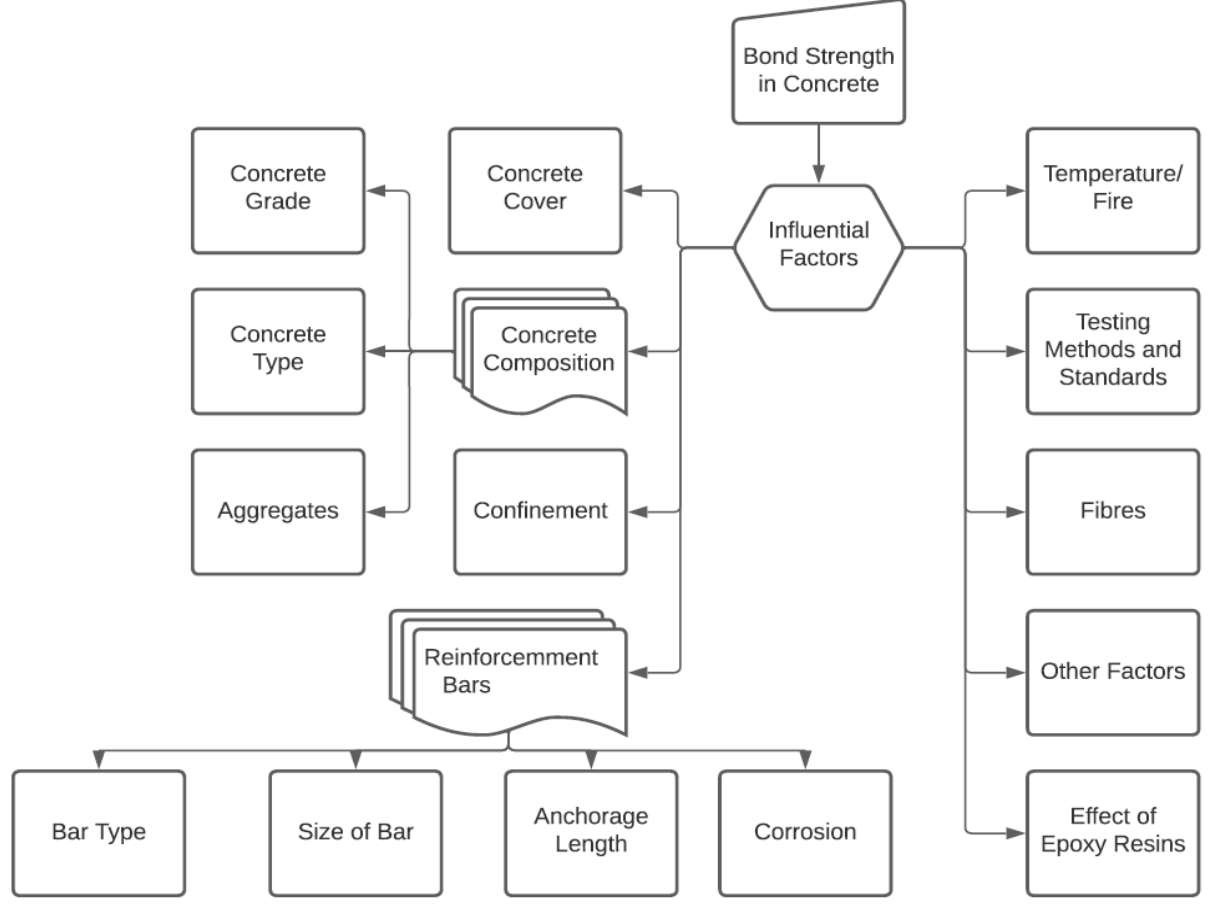
Figure 4. Various factors influencing the bond strength in concrete.